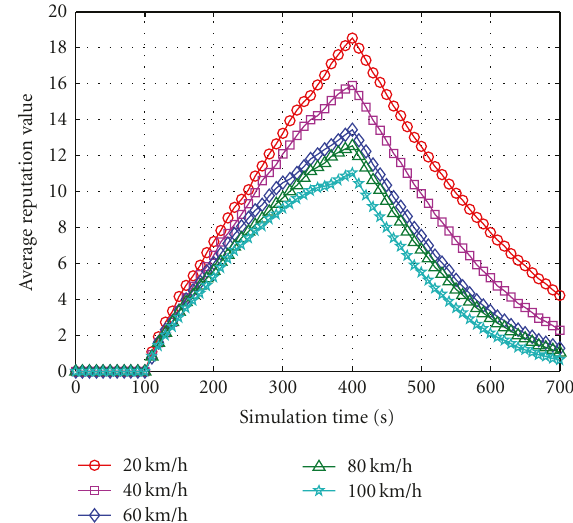
Figure 4: Average accumulation speed of event reputation value to vehicles under di ff erent vehicle